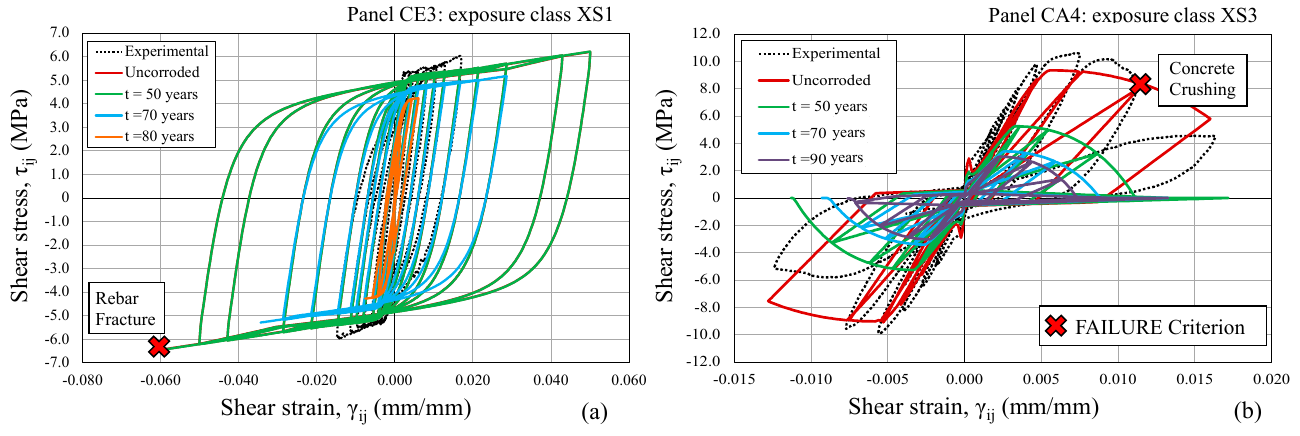
Figure 6. Critical points identification on hysteretic loops: ( a ) panel CE3 and ( b ) panel CA4.